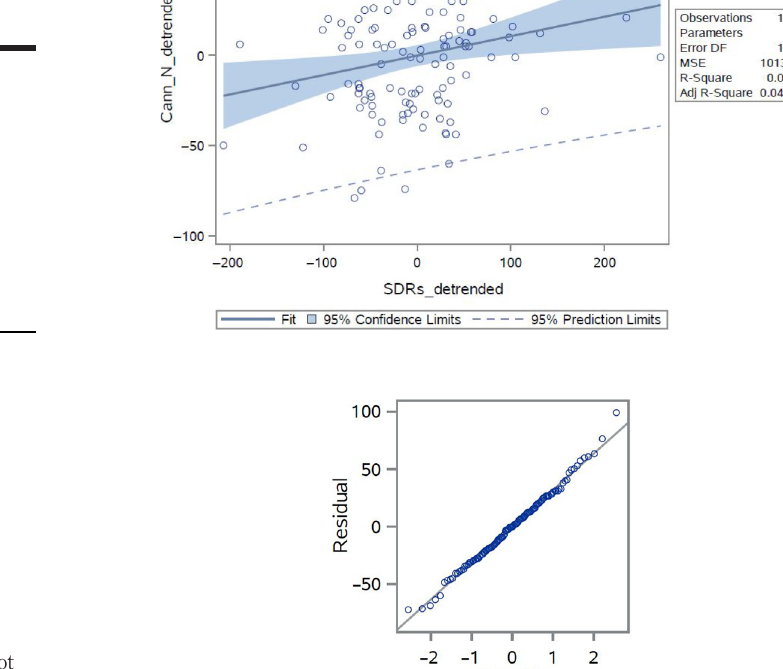
Figure 8. AMC Cann QQ